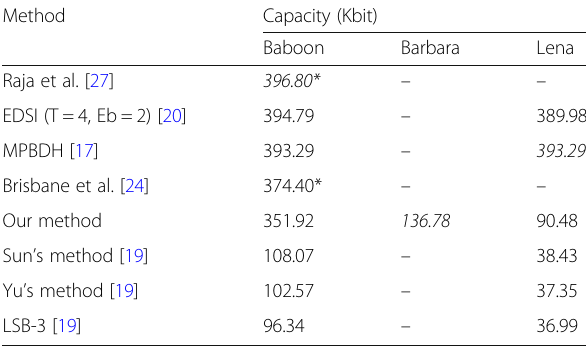
Table 2 Embedding capacity comparison results of different steganography